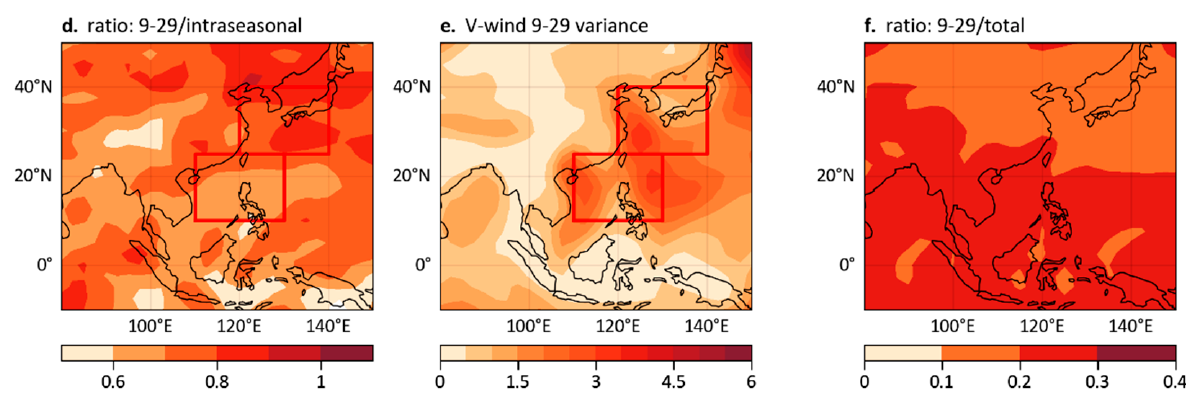
Figure 1. ( a ) Climatological-mean 1000 hPa meridional wind (denoted as V; color shading, m s − 1 ) during NDJFM, vectors indicate the horizontal winds (m s − 1 ); ( b ) variance of the 1000 hPa V (color, m 2 s − 2 ); ( c ) power spectrum (solid line) of the EAWM index. The two dashed lines denote the power spectrum for red noise at a significance level of 0.95 (upper) and 0.9 (lower); ( d ) ratios of the variance of 1000 hPa V: 9 − 29-day time scale to intraseasonal (9 − 61-day) time scale; ( e ) variance of the 1000 hPa V on 9 − 29-day time scale; ( f ) ratios of the variance of 1000 hPa V: 9 − 29-day time scale to total. Red boxes in ( a , b , d , e ) indicate the regions of (25° − 40°N, 120° − 140°E) and (10° − 25°N, 110°–130°E), in which the mean of 1000 hPa V anomaly is defined as the EAWM index.